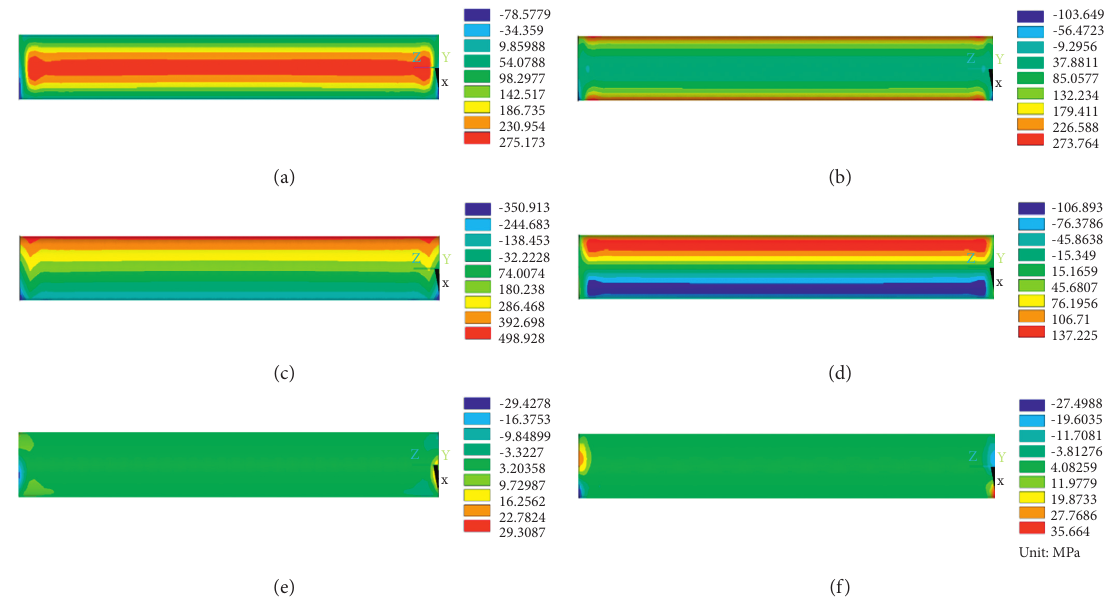
Figure 10: Distributions of six stress components in the pipe at 651 s: (a) pipe stress σ τ xy ; (e) pipe stress τ yz ; (f) pipe stress τ xz